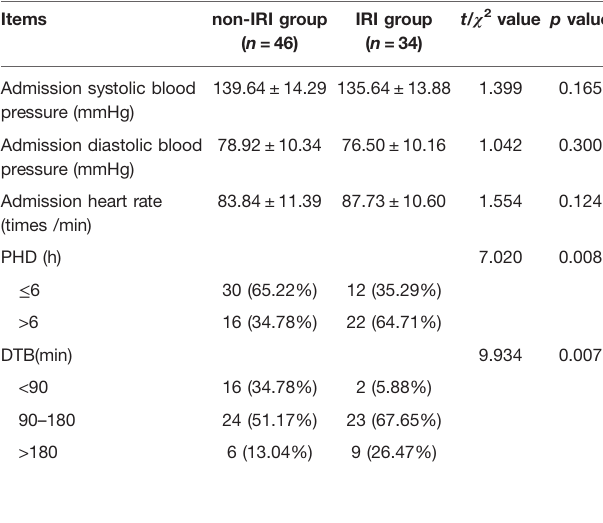
TABLE 2 | Clinical characteristics of patients ( n , x + s, %).